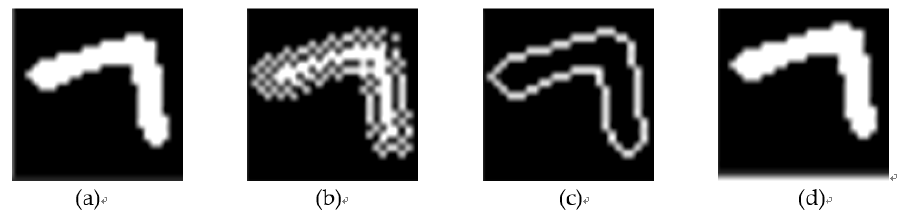
Figure5. Outputdataofeachfeature. ( a )Originalimage. ( b )Pointimage. ( c )Lineimage, ( d Figure 5. Output data of each feature. ( a ) Original image. ( b ) Point image. ( c ) Line image, ( d ) Face image.